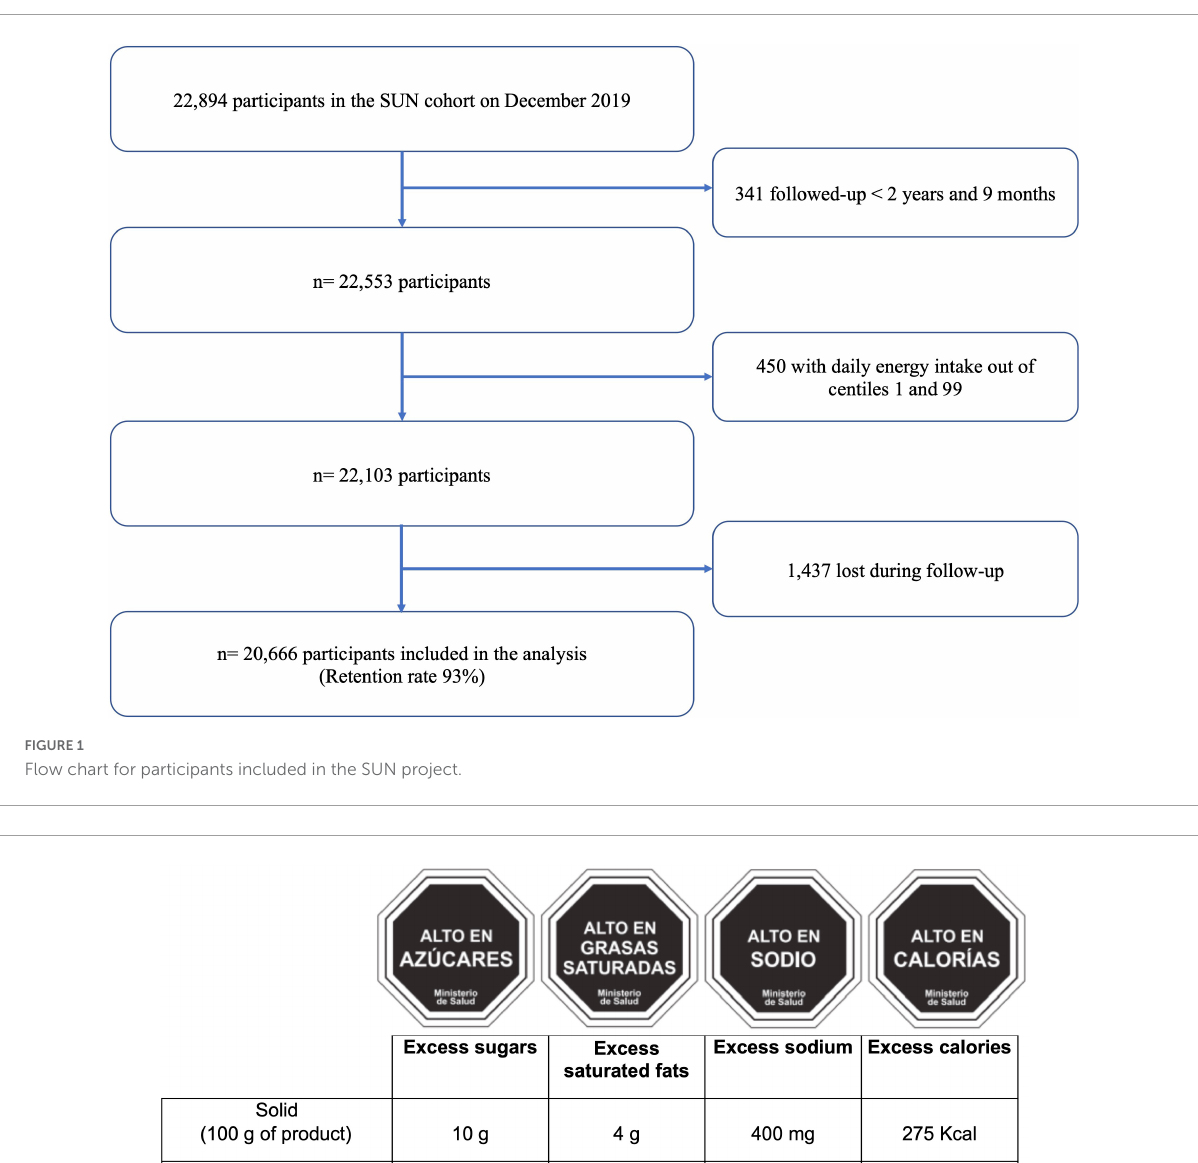
FIGURE2 The four approved warning labels in Chile implemented as front-of-package labels and Chilean score computation for warning labels in pre-packaged food and beverage. All octagons indicate “Ministry of